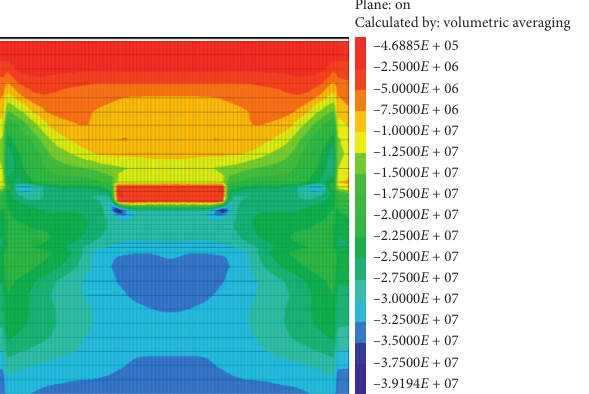
Contour of min. principal stress Plane: